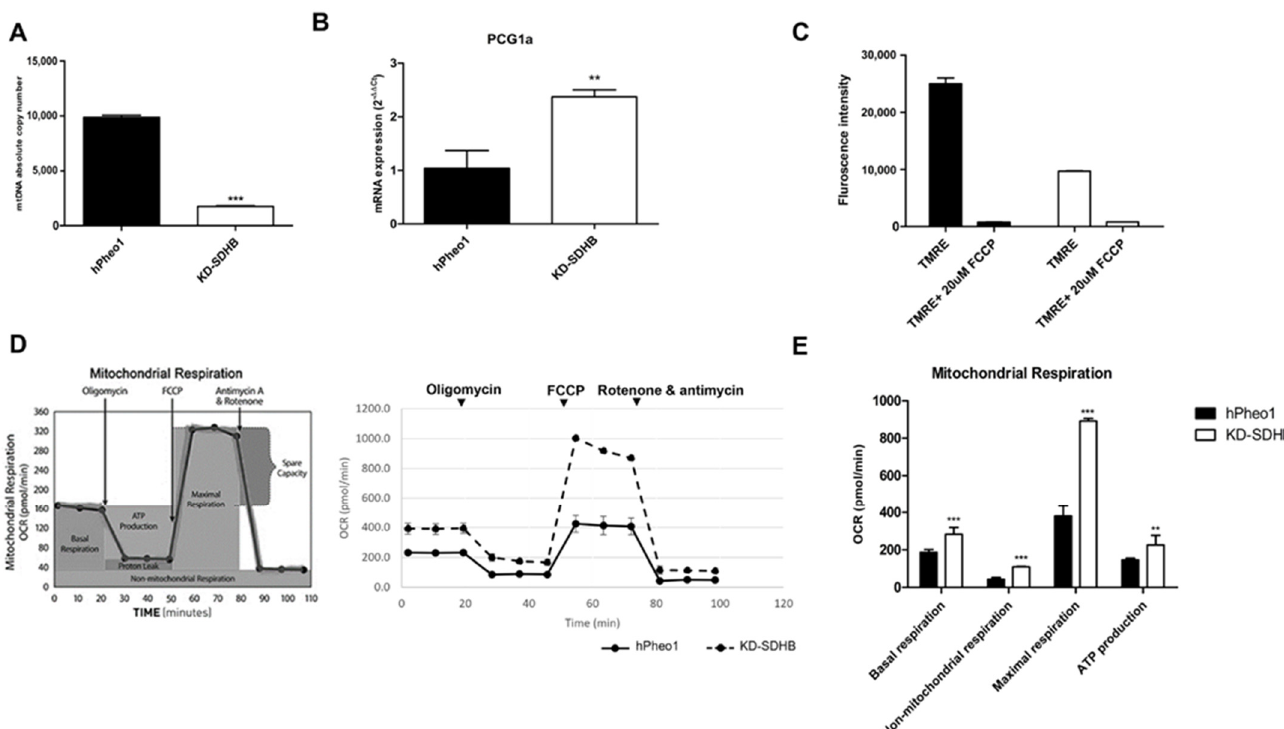
Figure 4. ( A ) Absolute mtDNA copy number in KD-SDHB and control cells (hPheo1 cell line). p -value was calculated by student’s t -test, *** ( p < 0.0001). ( B) Expression of PCG1 α mRNA using RT-qPCR (mean ± standard deviation) p-value was calculated by student’s t -test, ** ( p < 0.001). ( C ) Chart showing mean fluorescent intensity ± standard deviation from triplicate measurements of TMRE stained hPheo1cells +/ − treatment with FCCP. TMRE assay was performed to measure mitochondrial membrane potential in hPheo1 cell line (KD-SDHB and control). ( D ) The Agilent Seahorse XF24 analysis of mitochondrial function shows acute disruption of ATP-linked oxygen consumption in hPheo1 wild-type and KD-SDHB cells. Seahorse XF24 analysis using the Cell Mito Stress Test kit was performed (normalized to cell number). Respiratory chain stressor compounds were added to the culture at the indicated time points. ( E ) Individual parameters of mitochondrial function: basal respiration, nonmitochondrial oxygen consumption, maximal respiration, and ATP production, were calculated according to manufacturer’s protocol. Values are means ± standard deviation of at least three technical replicates at each time point (see experimental procedures for details). Student’s t ‐ test p values indicated as ** ( p < 0.001) and *** ( p < 0.0001).